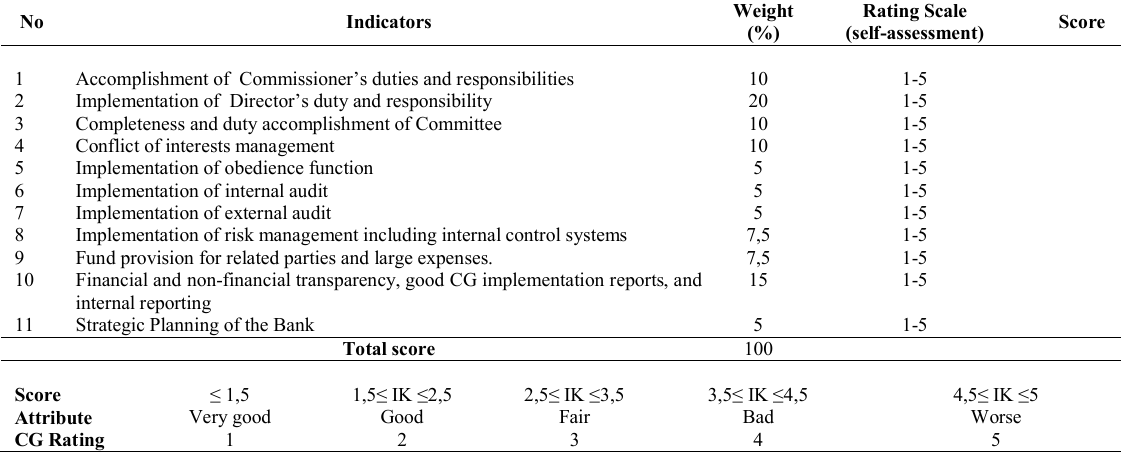
TABLE 1 C ORPORATE GOVERNANCE RATING PROCEDURE